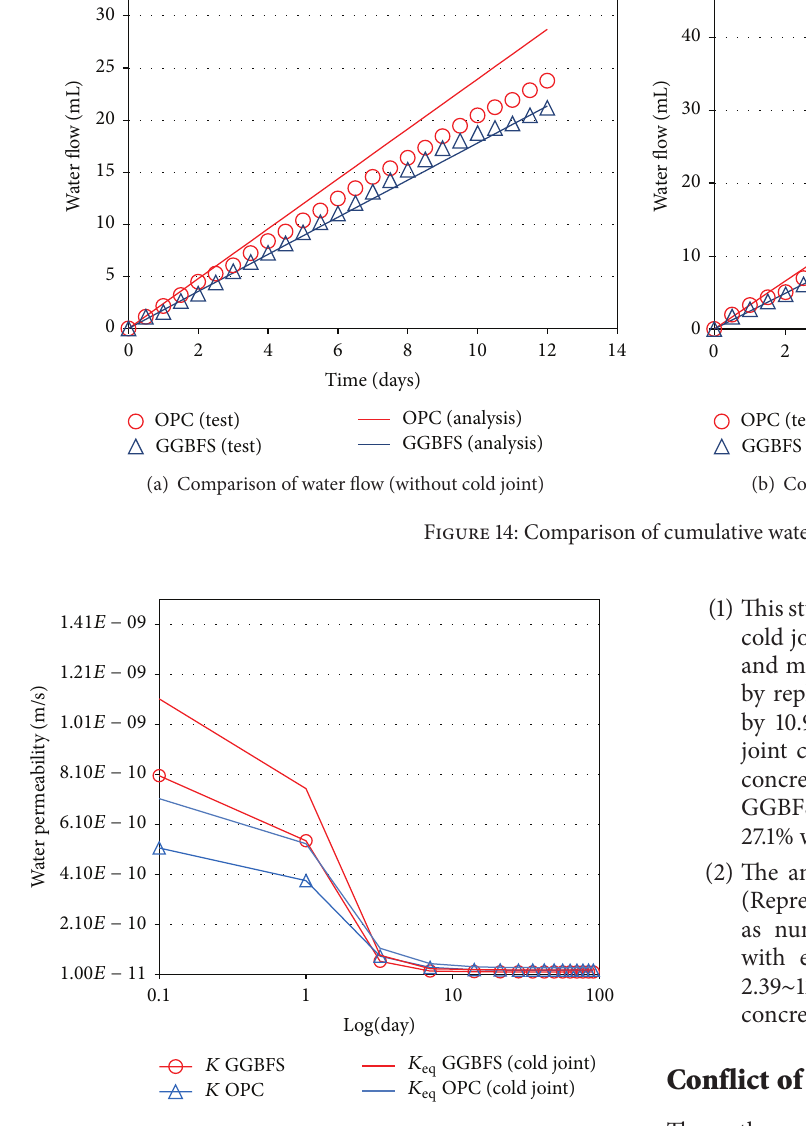
Figure 15: Simulated results of water permeability with time